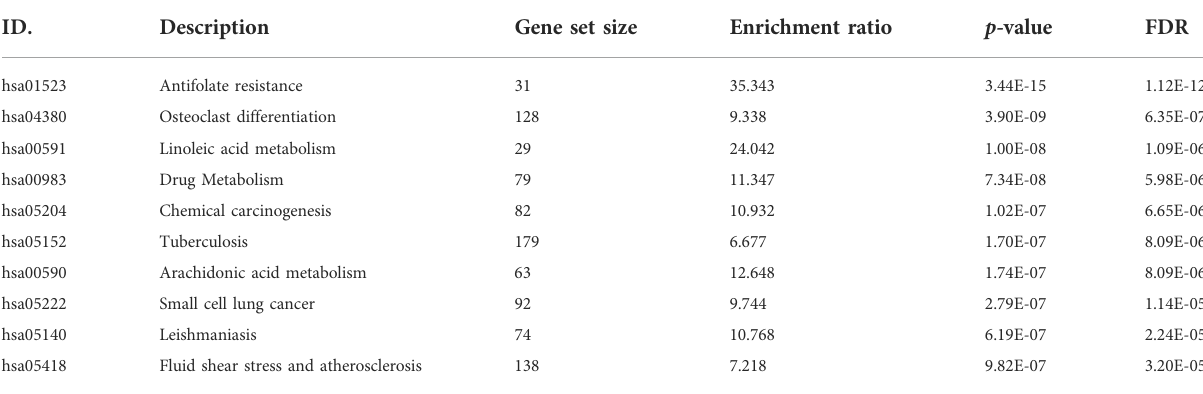
TABLE 2 The top 10 enriched KEGG